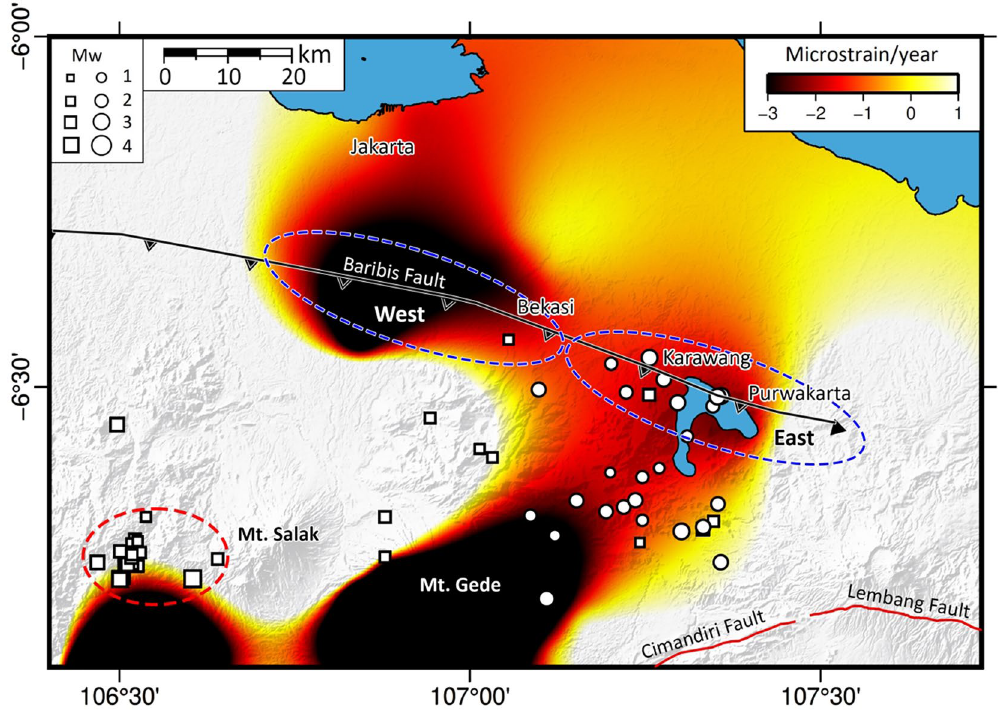
Figure 4. Map of dilatation rate based on Gunawan & Widiyantoro 14 for the study region. Positive and negative values indicate extension and compression, respectively. Squares and dots represent epicenters of relocated events recorded by the borehole seismometers used by Damanik et al. 18 and deployed in this study, respectively. Note that the western part of the Baribis Fault has a high compression rate and fewer earthquakes compared to the east, which may be related to fault locking. The dashed ellipse depicts the location of a swarm in the study area (see also Sianipar et al. 34 and Supendi et al. 35 ). The Generic Mapping Tools (GMT) version 6.0 59 (https:// www. gener ic- mappi ng- tools. org/) was used to make this